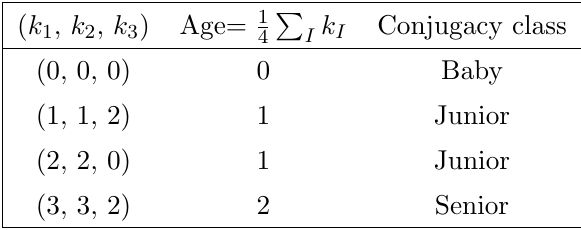
Table 9. The conjugacy classes of the chiral orbifold model C 3 = Z 4